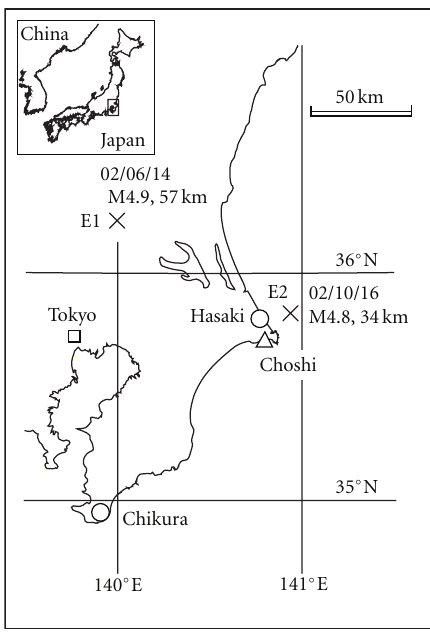
Figure 1: A map showing observation sites of two electric fields ( (cid:2) ) at Hasaki and Chikura, a strong-motion seismometer at Choshi of the K-NET ( (cid:2) ), and the epicenter (E1) of the earthquake on 14 June 2002, and E2 on 16 October 2002. The electric field observations were conducted by the use of the 805 m borehole antenna at Hasaki and the 850 m borehole antenna at Chikura to measure the vertical component of the electric field. Similar electric observations have been conducted in the central part of Japan at 11 sites